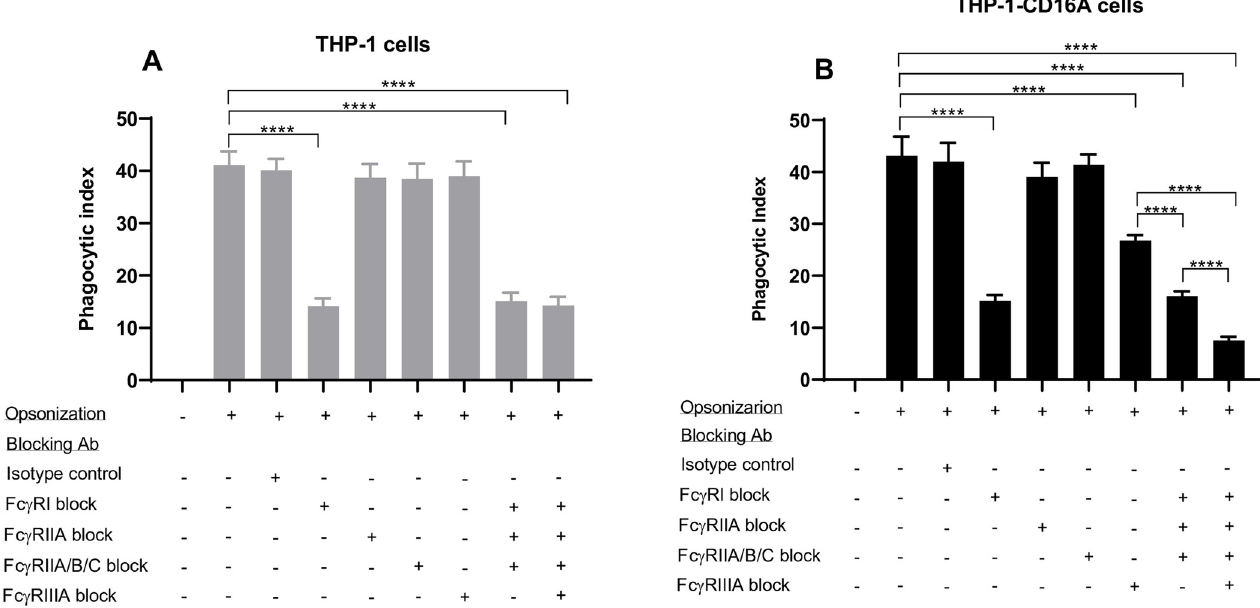
Fig 5. Fc γ R utilization by THP-1 and THP-1-CD16A cells in the phagocytosis of IgG-opsonized human erythrocytes. THP-1 cells were differentiated to macrophages by treatment with PMA (100 ng/mL) as described in the methods. (A) THP-1 cells. (B) THP1-CD16A cells. Opsonization: (-) indicates erythrocytes were non-opsonized (incubated with phosphate buffered saline), (+) indicates erythrocytes were opsonized with a polyclonal anti-human RhD antibody (WinRho SDF TM ). The contribution of each Fc γ R to the phagocytosis was evaluated using Fc region deglycosylated blocking antibodies (final concentration of 10 μ g/mL each): anti-Fc γ RI (clone 10.1), anti-Fc γ RIIA (clone IV.3), anti-Fc γ RIIA/B/C (clone AT10), or anti-Fc γ RIIIA (clone 3G8). The deglycosylated mouse IgG1 (clone MOPC-21) and deglycosylated mouse IgG2b (clone MPC-11) were used in combination as isotype controls (final concentration of 10 μ g/mL each). The phagocytic index was calculated as the number of erythrocytes engulfed per 100 macrophages. Data are presented as the mean ± the standard deviation of five independent experiments. For panels A and B, the statistical analysis was performed with a one-way analysis of variance (ANOVA) and Tukey’s multiple comparisons test ( ���� : p <